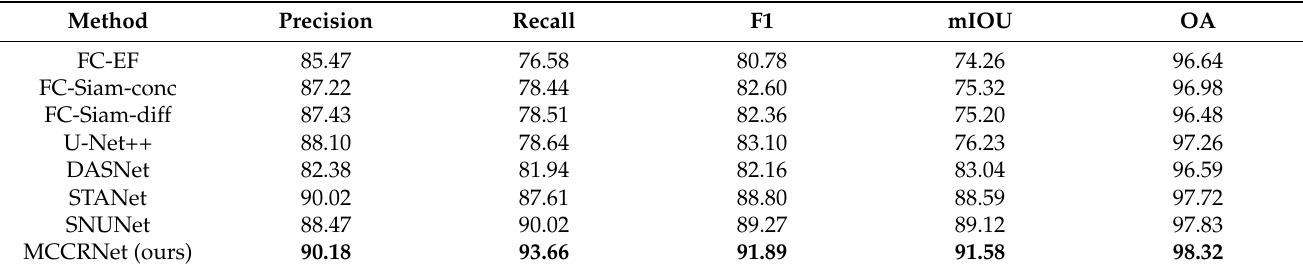
Table 8. Comparison results on Google Data GZ dataset. The bold numbers indicate the best results. Method